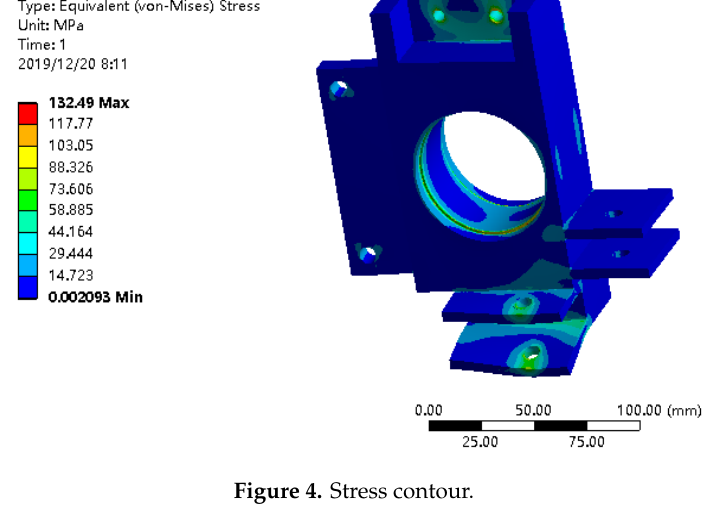
Figure 4. Stress contour.